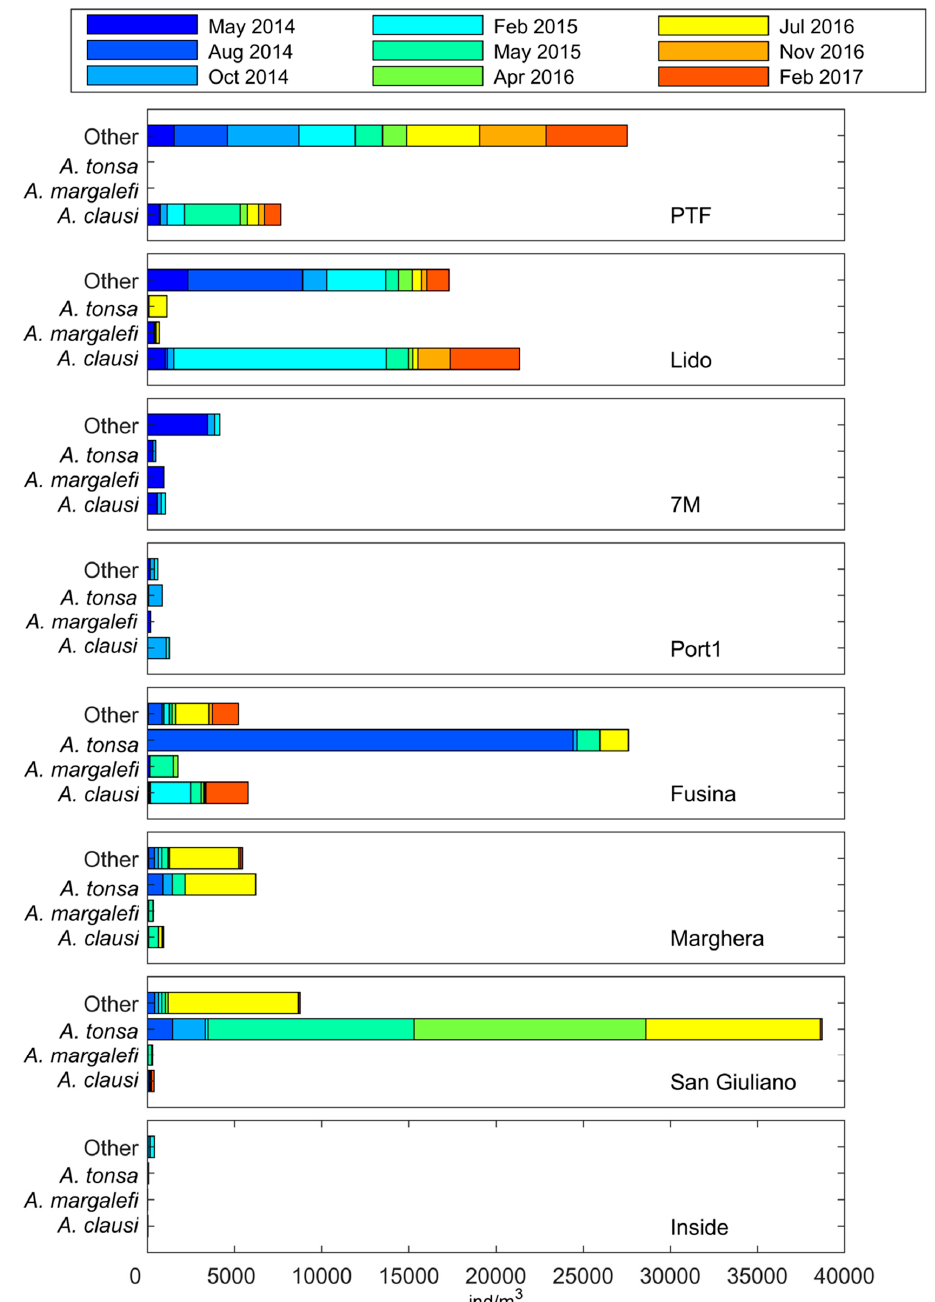
Figure 8. Seasonal relative abundance of A. tonsa with respect to other Acartia species and remaining zooplankton at stations for the 2014–2017 period. Data related to 7M, Port1, and inside refer only